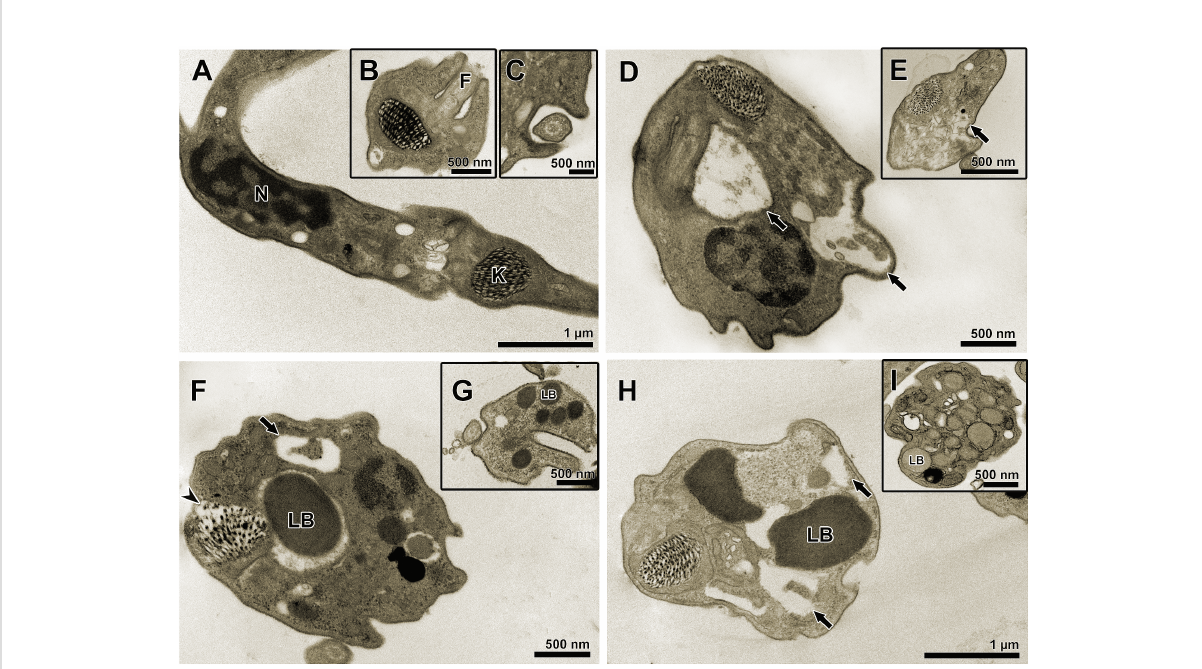
FIGURE 3 Transmission electron microscopy of T. cruzi bloodstream trypomastigotes treated for 24 h with Bz, AMD or their combination, showing the predominance of the phenotype generated by AMD in the combination Bz + AMD. (A – C) Untreated parasites exhibiting organelles with typical morphology; (D, E) Bz MT (IC 50 /24 h = 8.82 m M); (F, G) AMD MT (IC 50 /24 h = 13.40 m M) and (H, I) Bz:AMD Comb (Bz: IC 50 /24 h = 3.94 m M; AMD: IC 50 /24 h = 15.0 m M). Black arrows indicate vacuolization and disorganization of the cytoplasm; arrowhead indicates disorganization of the kinetoplast. N, nucleus; K, kinetoplast; F, fl agellum; LB, lipid